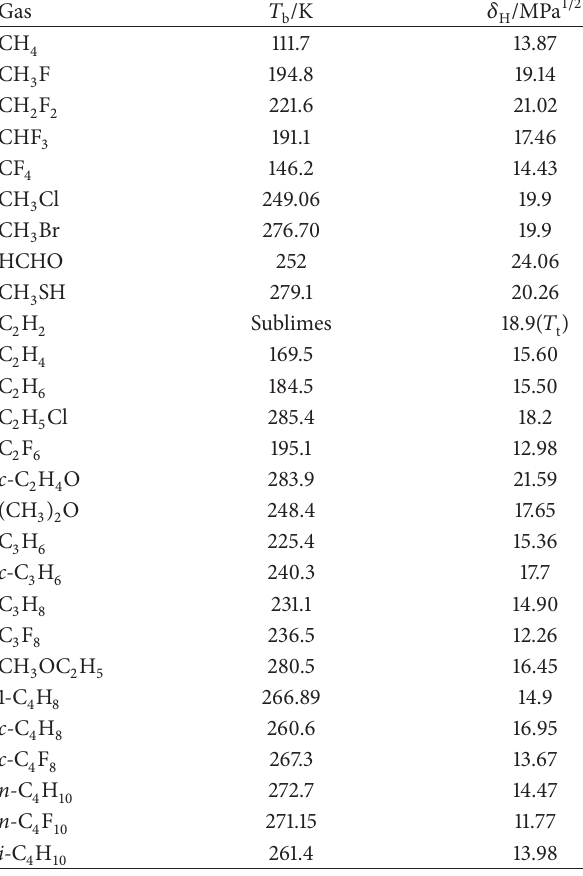
Table 2: Selected solubility parameters of liquefied organic gases at their boiling